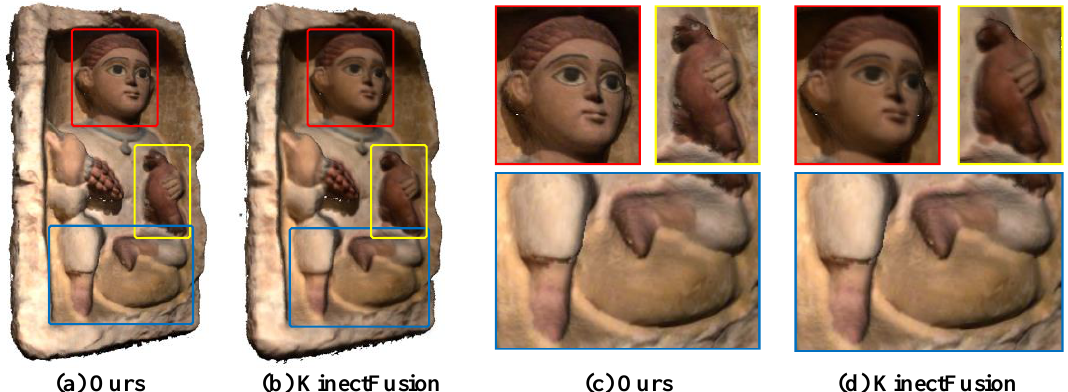
Figure 7. The reconstruction results of the Tomb Statuary dataset. Comparing with the classical weighted average fusion method [6] ( b,d ), our results ( a,c ) can achieve better texture clarity and color fidelity.